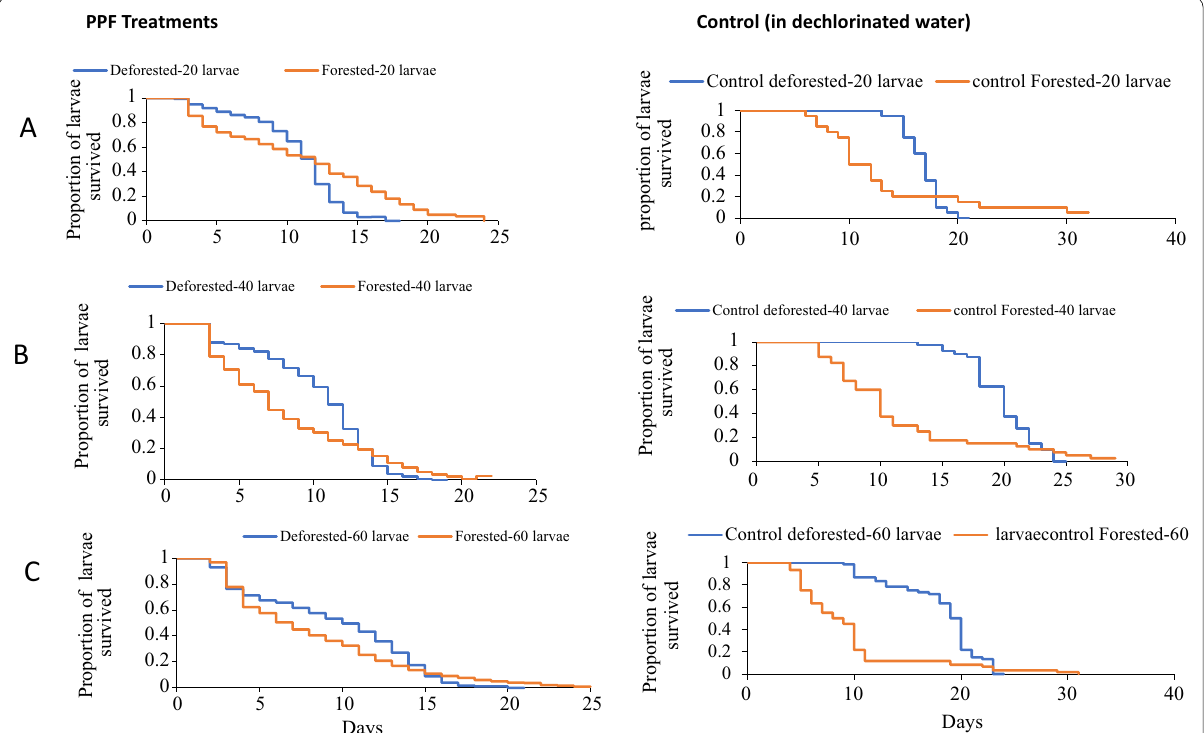
Fig. 7 The impact of pyriproxyfen at 0.3 ppm on An. gambiae s.s. larvae survival time in forested and deforested area at density of 20, 40 and 60 larvae ( A , B and C respectively). Experiments were done 6 times in 3 rounds